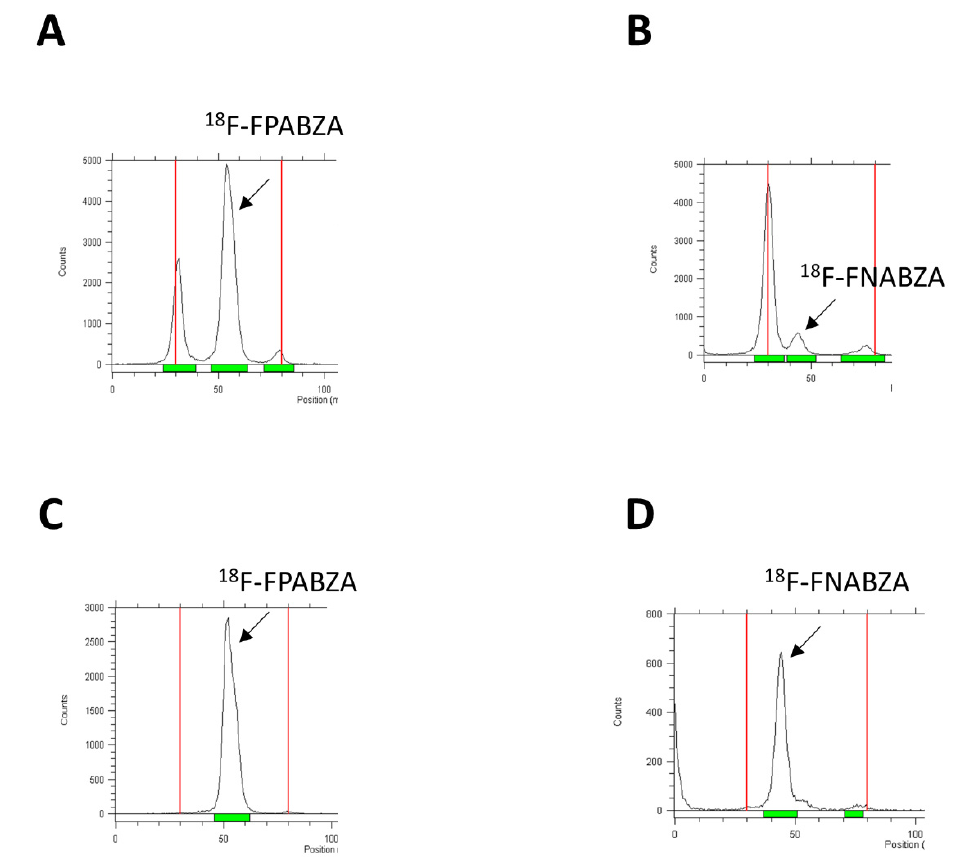
Figure 2. Radio-TLC analysis of ( A , B ) the crude products and ( C , D ) the purified 18 F-FPABZA and 18 F-FNABZA. The radiolabeling efficiency and the radiochemical purity were determined